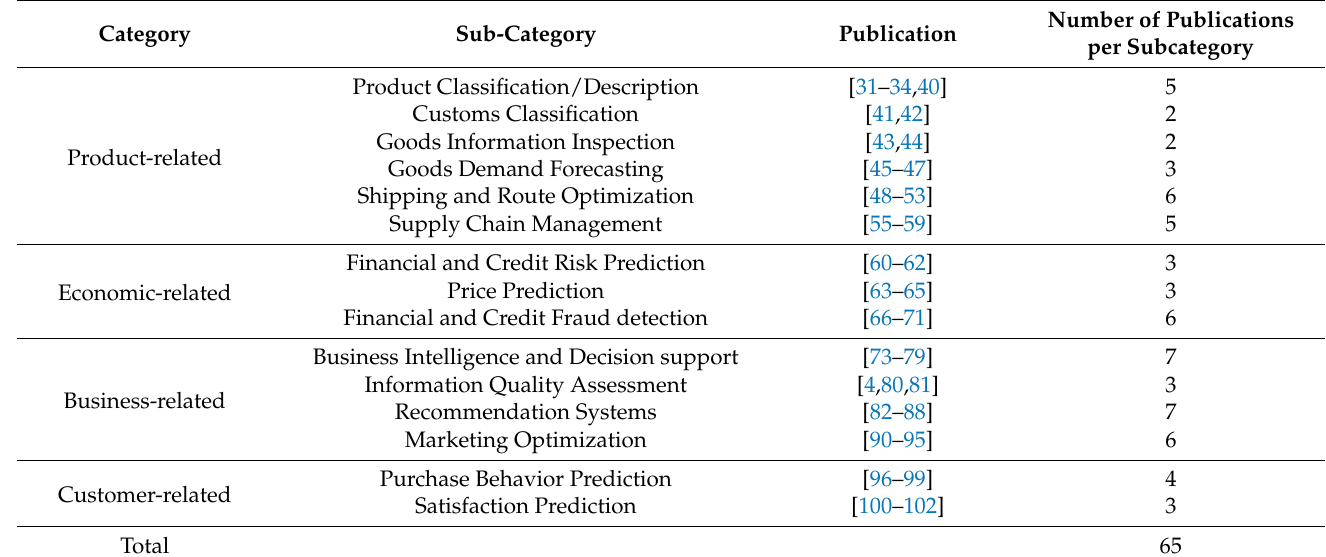
Table 2. Applications of fusion techniques in e-commerce